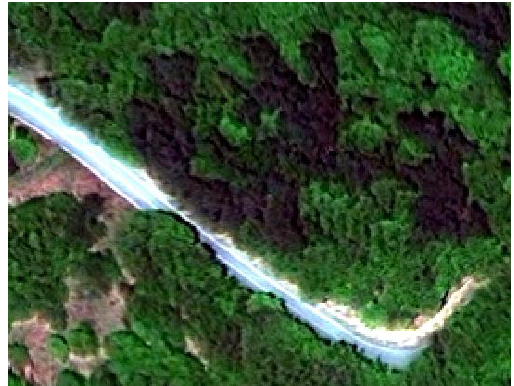
Figure 12. A part of the fused image.